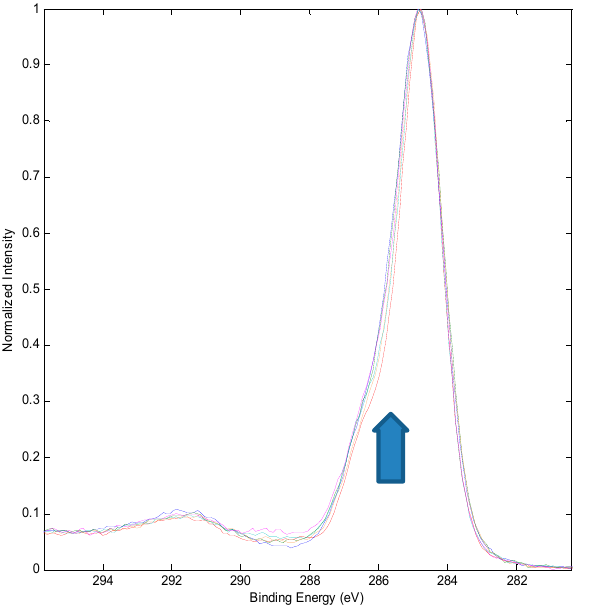
Figure 4. Overlapped C 1s spectra for control and PES samples treated with VUV photo-oxidation. The arrow indicates increasing treatment time for 0, 5, 10, 15, 30, and 60 min. Table 1. Assignments [15] and % areas for the C 1s peaks in Figure 4 as determined by curve-fitting. Carbons (1), (2), and (3) are illustrated in Figure 1.